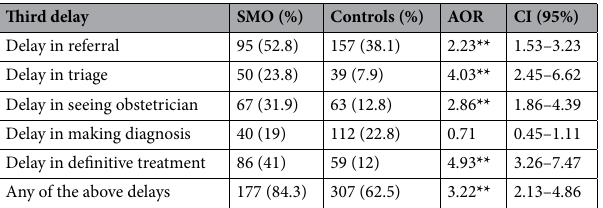
Third delay SMO